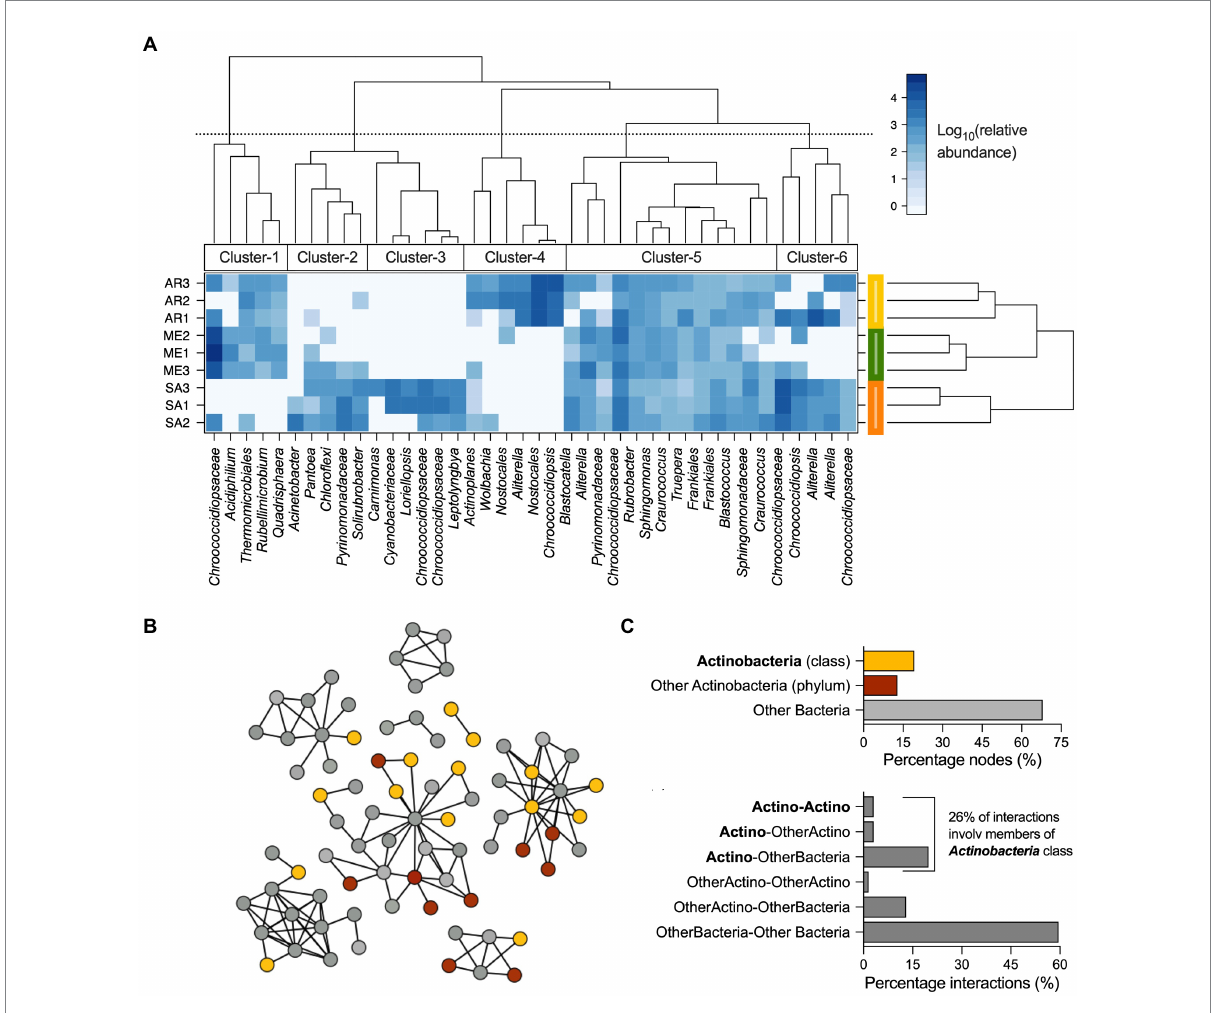
FIGURE 5 Distribution and interaction of bacteria associated with stones across the three climates. (A) Two-way cluster analysis of stone communities; most abundant bacterial OTUs (>0.4% relative abundance) are reported and how they are grouped in clusters based on their presence in the different climatic regions is indicated. (B) Co-occurrence correlation network of the bacterial OTUs associated with stones from Tunisian Roman ruins. Diagram of co-occurrence bacterial network with nodes colored by their taxonomic affiliation. (C) Classification of interactions (considering both negative and positive) based on the taxonomic affiliation of nodes as members of Actinobacteria class (“Actino”), members of Actinobacteria phylum different than Actinobacteria class (“other Actino”), other bacteria (all the remining taxonomic groups; “bacteria”); the possible interactions are “Actino-Actino,” “Actino-OtherActino,” “Actino-Bacteria,” and